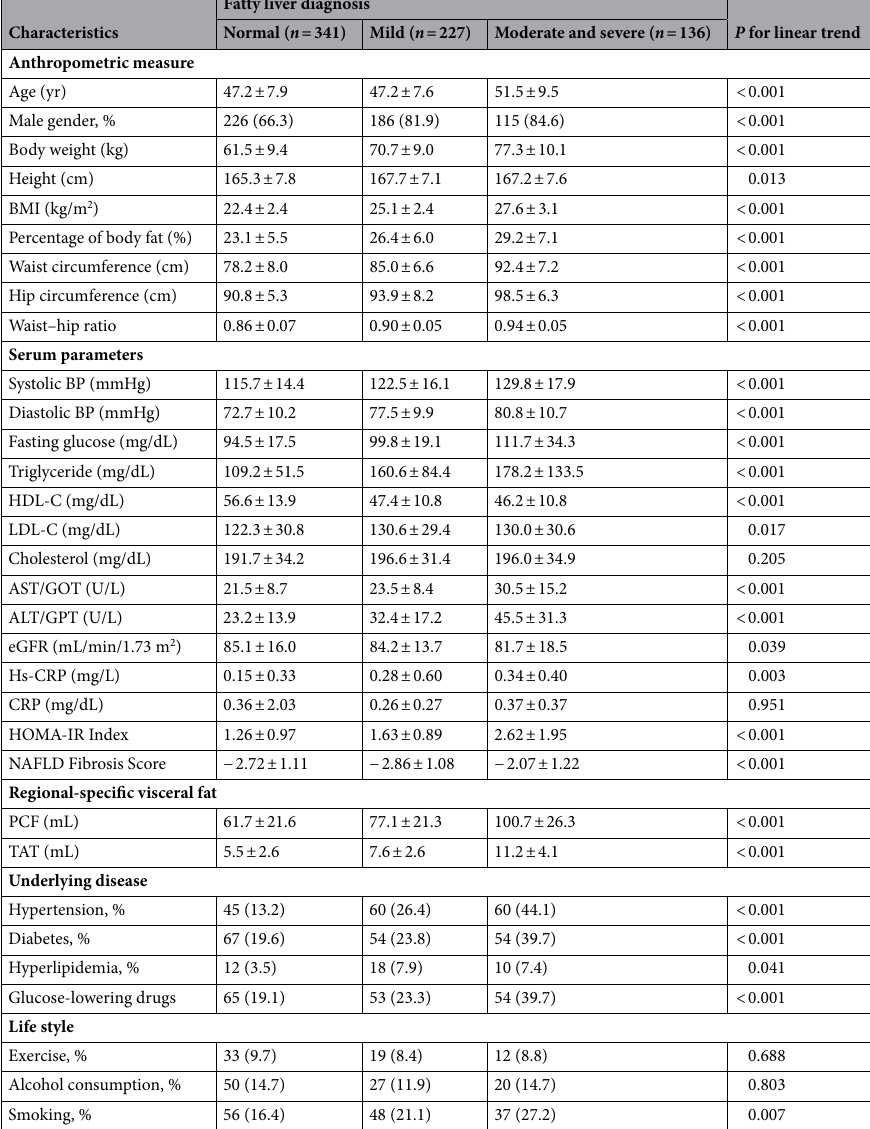
cholesterol, LDL low-density lipoprotein cholesterol, eGFR estimated glomerular filtration rate, hs-CRP high sensitivity C-reactive protein, PCF pericardial fat, TAT thoracic peri-aortic adipose